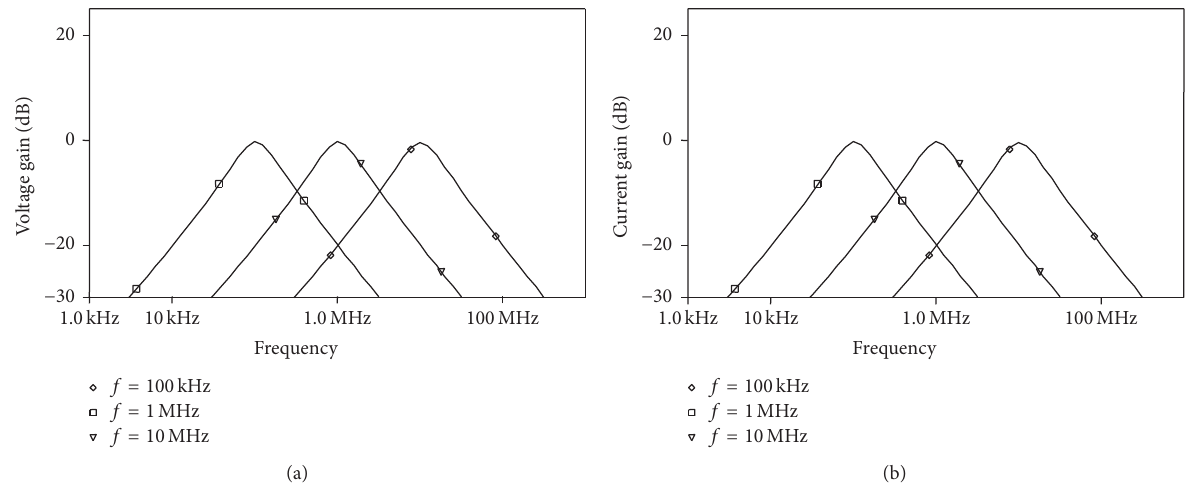
Figure 8: BP responses for 𝑓 0 = 100 KHz, 1 MHz, and 10MHz keeping 𝑄 0 fixed at 1 for (a) VM and (b) CM